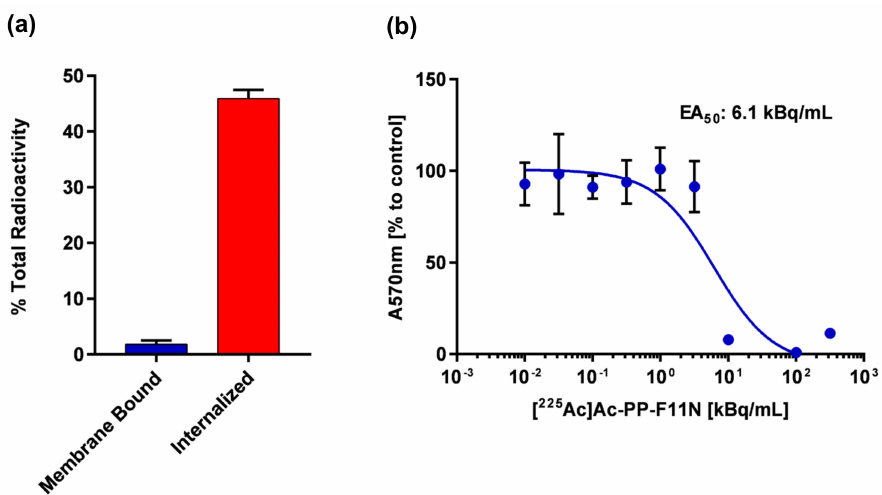
Figure 1. In vitro characterization of [ 225 Ac]Ac-PP-F11N in A431 / CCKBR (cholecystokinin B receptor) cells. ( a ) Internalized and membrane-bound activity after 2 h treatment with [ 225 Ac]Ac-PP-F11N in A431 / CCKBR cells. Bars represent mean ± SD. ( b ) Proliferation of [ 225 Ac]Ac-PP-F11N-treated A431 / CCKBR cells at indicated doses after 2 h internalization followed by 24 h incubation. Points represent mean ± SD. The obtained curve was used for EA 50 calculation. All experiments were performed at least in triplicate. The SDs at 10 1 , 10 2 , and 10 2.5 kBq / mL were below 2.6% and are not visible in the